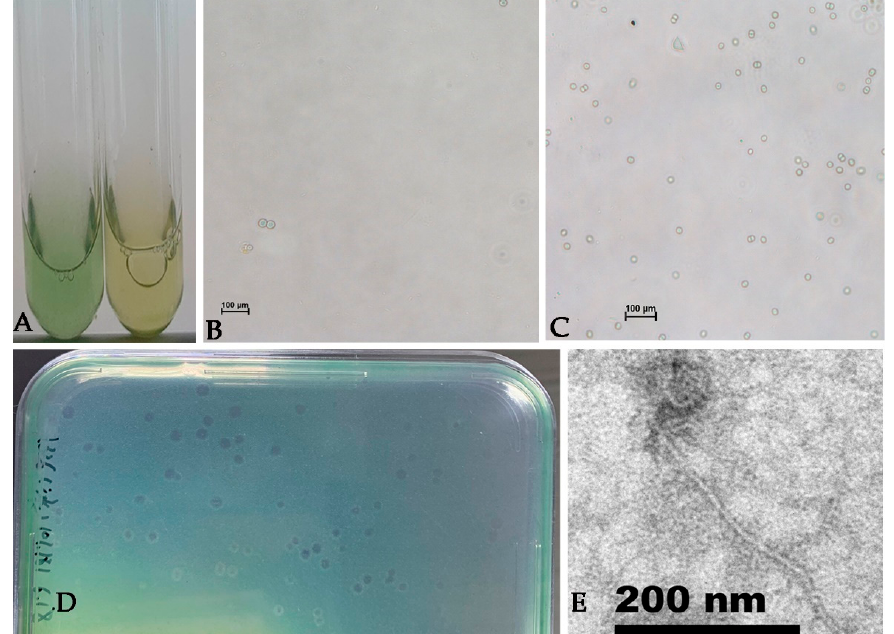
Figure 1. Micro- and macrographs of M. aeruginosa FACHB-1326 cultures, plaques, and negatively stained Mae-Yong1326-1. ( A ) Macrograph of a normal culture (left picture) and a M. aeruginosa FACHB-1326 culture infected with Mae-Yong1326-1 (right picture); ( B ) micrograph of a M. aeruginosa FACHB-1326 culture infected with cyanophage Mae-Yong1326-1. Scale bar = 100 µ m; ( C ) micrograph of a normal culture of M. aeruginosa FACHB-1326. Scale bar = 100 µ m; ( D ) plaques developed by Mae-Yong1326-1 on M. aeruginosa FACHB-1326 lawn; ( E ) a transmission electron micrograph of cyanophage Mae-Yong1326-1. Scale bar represents 200